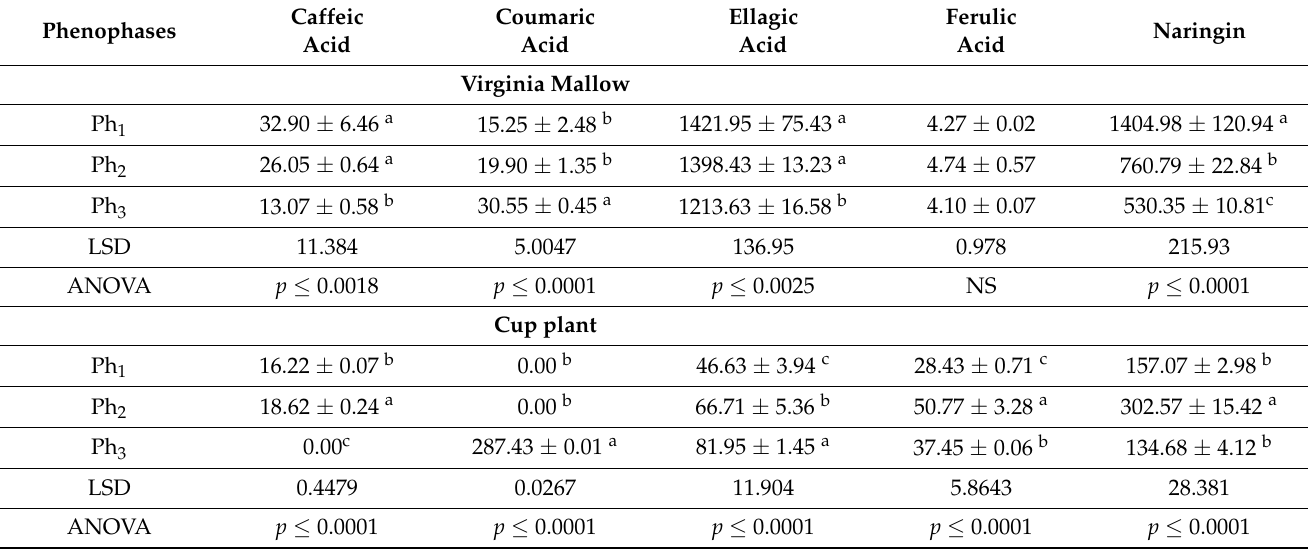
Table 4. Individual polyphenolics (mg/L) in leaves of Virginia mallow and cup plant leaves in different